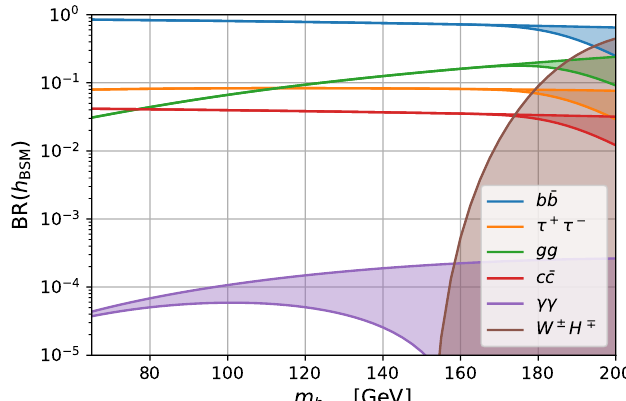
Figure 16. Branching ratios of h BSM in the cH ( Wh BSM ) benchmark scenario as a function of . The decays h and h ± H ∓ additionally depend on m m h BSM → γγ BSM → W BSM dependence in the remaining BRs through the total decay width. The bands for each BR indicate the impact of this dependence for 150 GeV < m < 300 GeV H ±